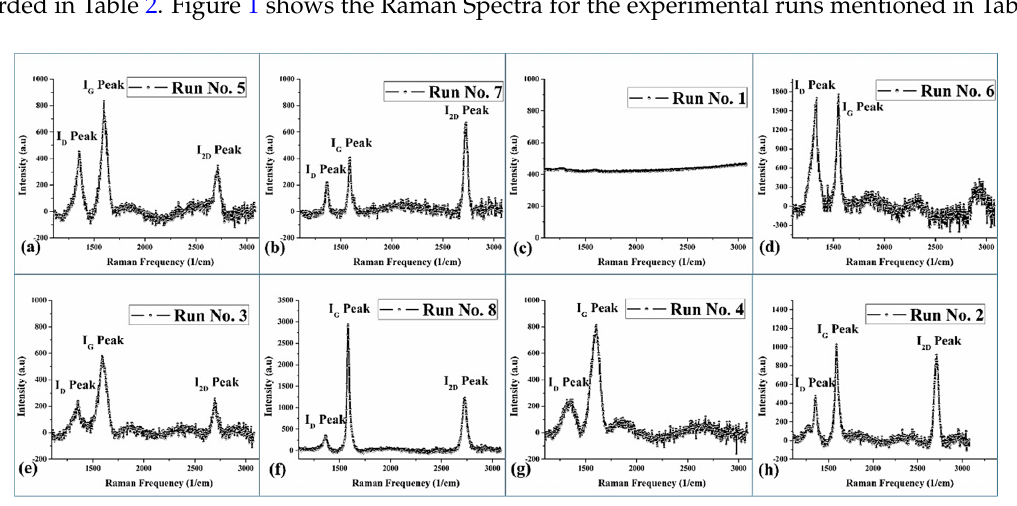
Table 2. Full ‐ factorial DoE analysis.